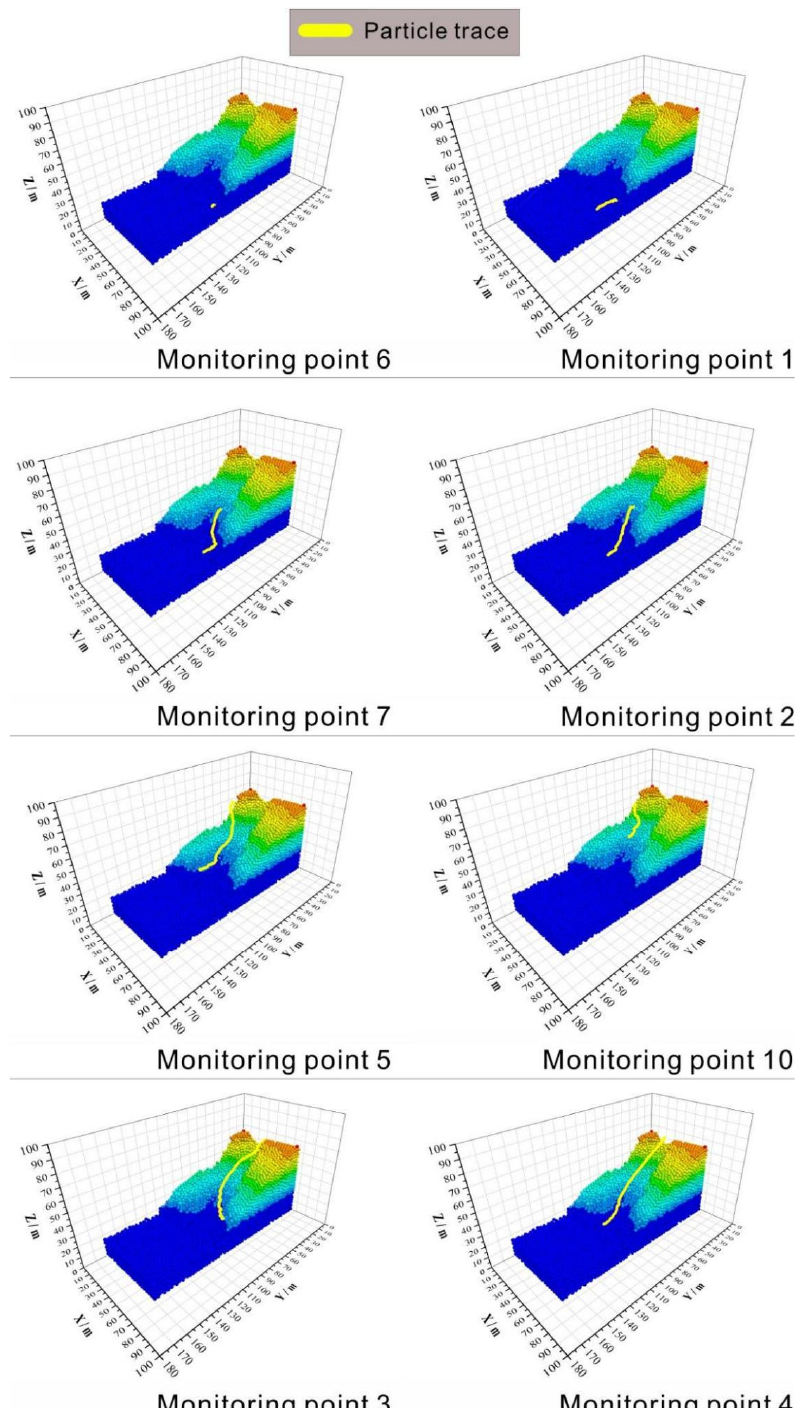
Figure 17. Movement trajectories of the monitoring particles.